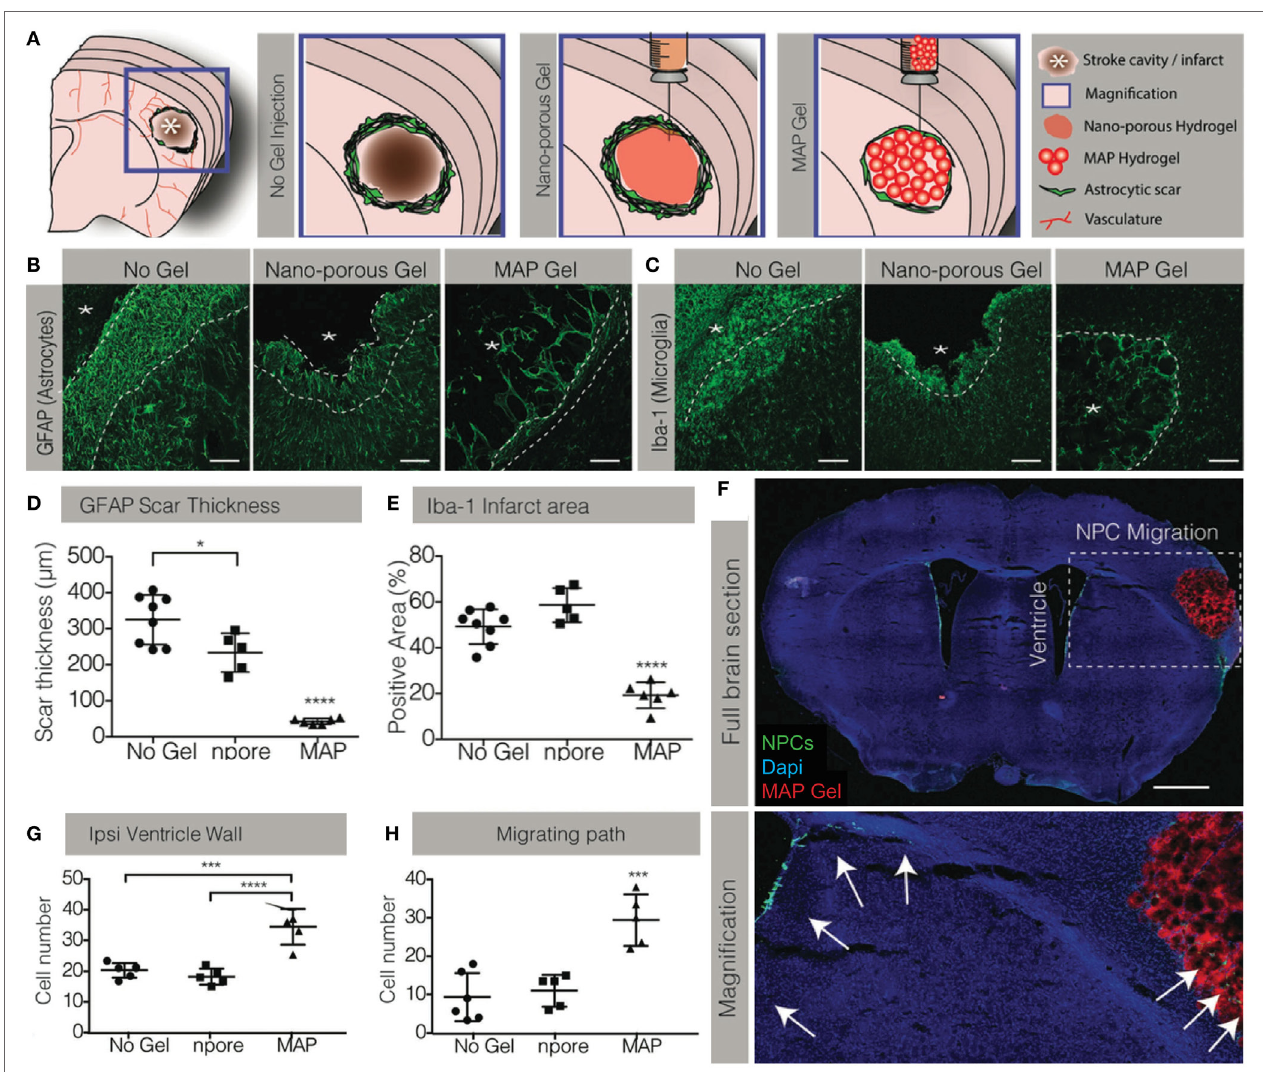
FiGURe 2 | Manipulating the biomaterial structure can drastically change the host response. (A) A microporous (MAP) hydrogel was synthesized using HA-RGD microbeads. The gel had the same bulk modulus and chemical structure as a nanoporous hydrogel. Representative images of the (B) astrocytic and (C) microglial responses in the stroke cavity with no gel, nanoporous gel and MAP gel. (D) The MAP hydrogel significantly reduced the glial scar thickness compared to the nanoporous hydrogel. (e) The microglial response was only reduced by the microporous MAP hydrogel; despite possessing the same modulus and biochemical signaling, the nanoporous hydrogel did not affect the response. (F) Representative images of endogenous neural progenitor cells (NPCs) stimulated by the MAP hydrogel. (G) Only the microporous MAP hydrogel increased the number of NPCs in the subventricular zone and (H) migrating into the infarct. Reproduced with permission from Nih et al.